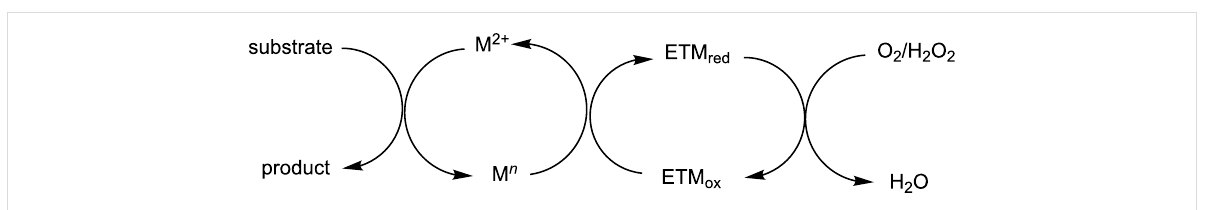
Figure 4: Biomimetic catalytic oxidation in the presence of electron-transfer mediators (ETMs).